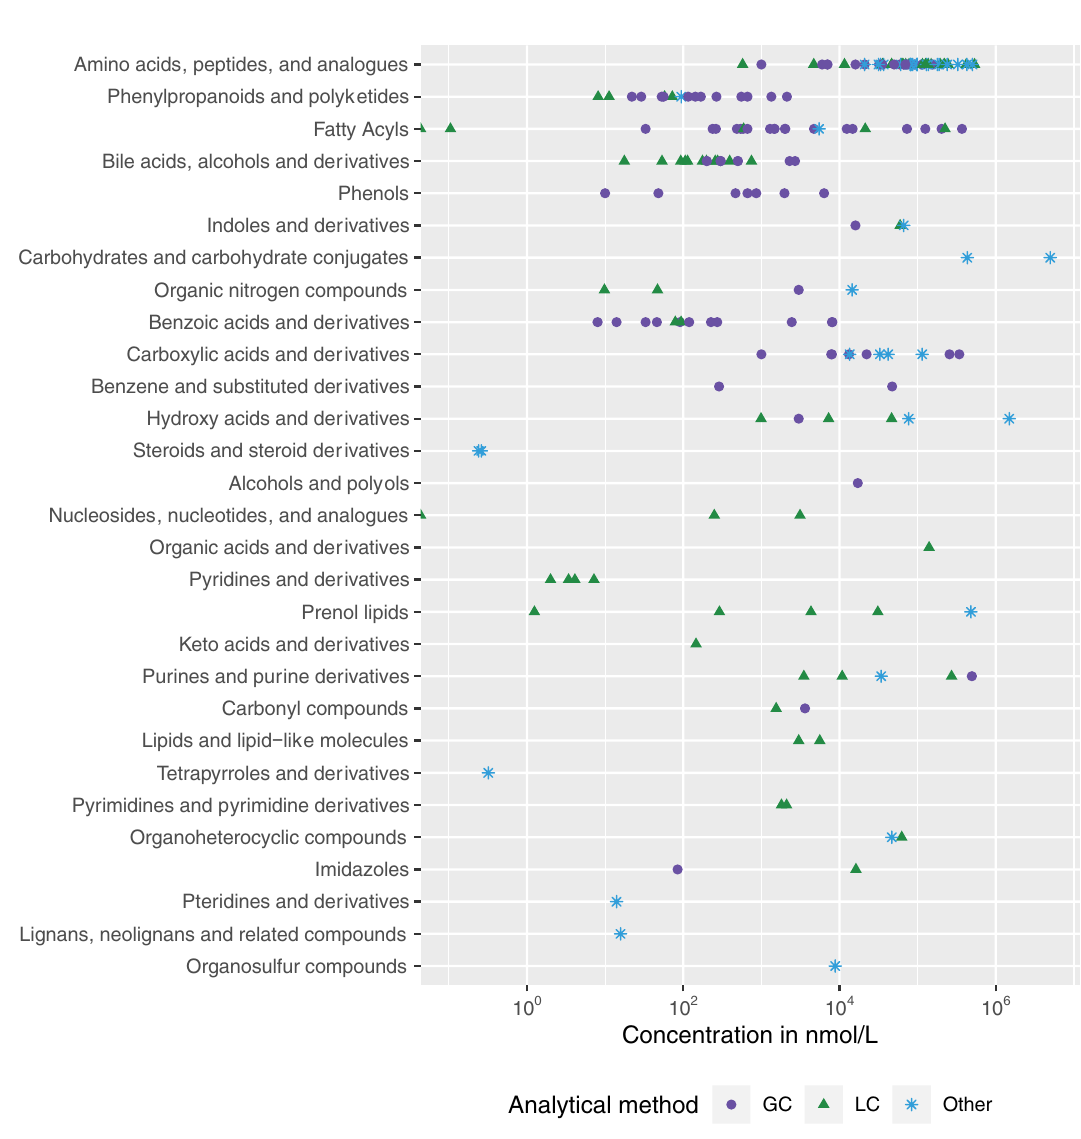
Figure 3. Concentrations of 152 microbial metabolites in the Exposome-Explorer database measured in human blood with different types of analytical methods. GC—gas chromatography; LC—liquid